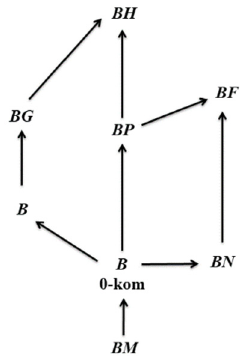
Figure 1. The relationship of BN -algebra with other algebras